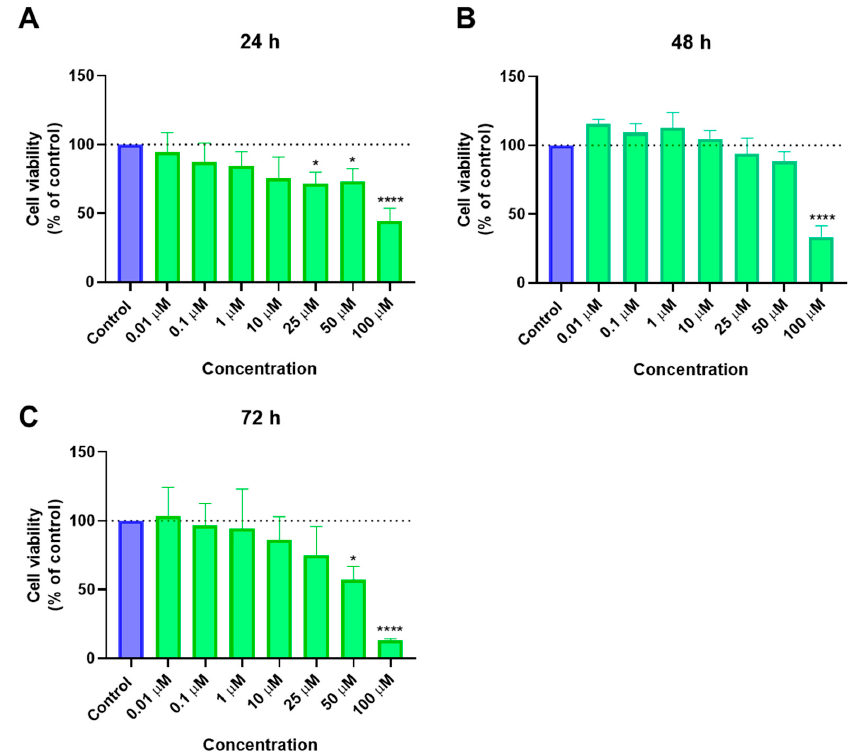
Figure 14. Cytotoxic results of A549 after exposure to increasing concentrations of saquinavir (0.01–100 µ M) for 24 h ( A ), 48 h ( B ), and 72 h ( C ). Control cells were treated with 0.01% DMSO (vehicle). Cell viability was obtained using the MTT assay and the results are given as the mean ± SEM ( n = 3). * Statistically significant vs. control (vehicle) at p < 0.05; **** statistically significant vs. control (vehicle) at p < 0.0001.